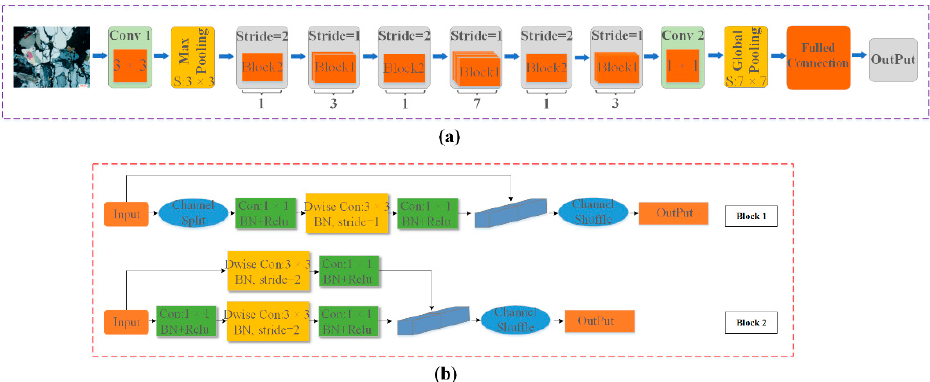
Figure 7. Network structure: ( a ) ShuffleNetV2 architecture; ( b ) block module structure.